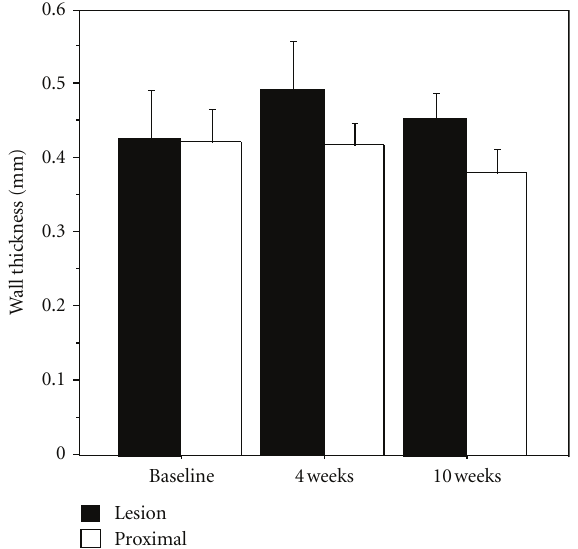
Figure 6: MRI-snakes-measured arterial wall thickness (mm) in lesion and proximal segment at baseline, 4 and 10 weeks, mean values for 3 animals, 18 slices from PTA-treated region, and 18 slices from proximal